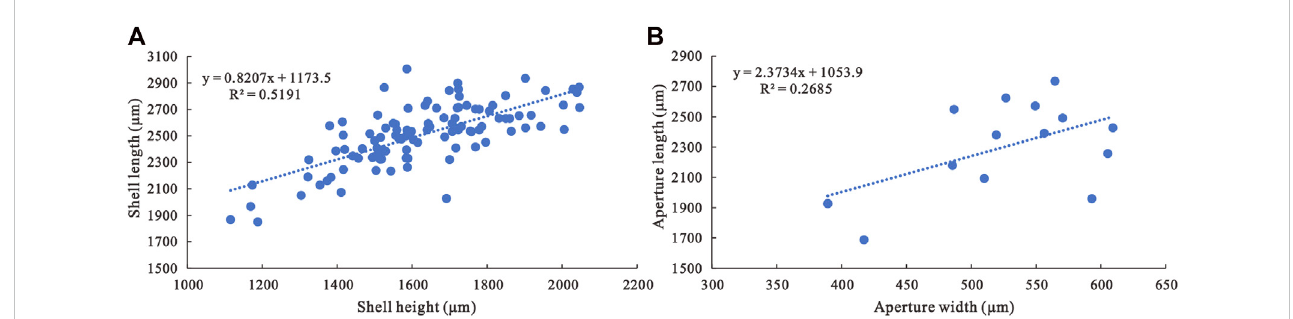
FIGURE 3 Morphological parameter analyses of A. plana . (A) Shell length/shell height ratio of A. plana (N=105). (B) Aperture length/aperture width ratio of A. plana